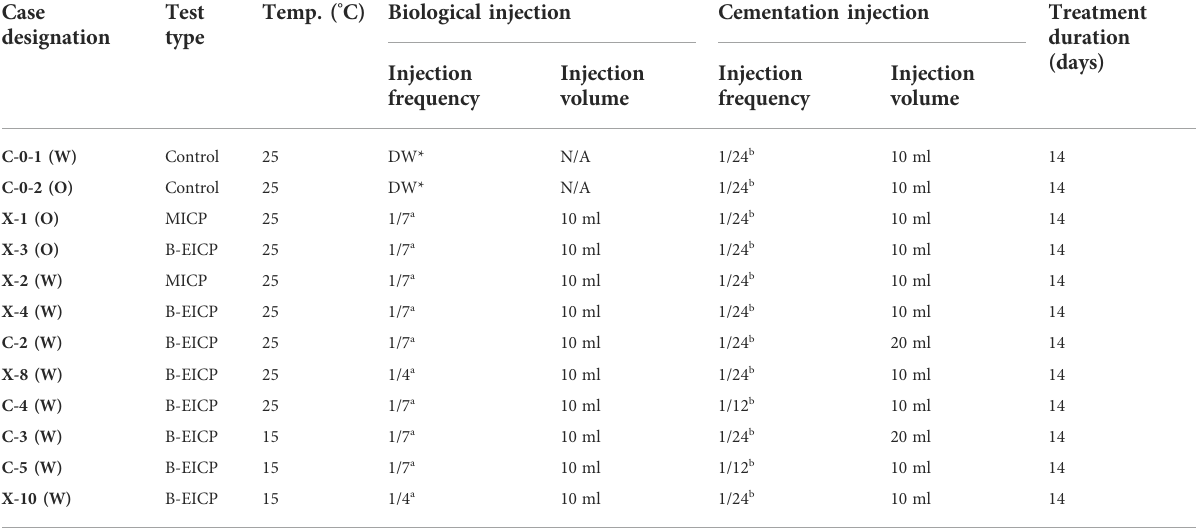
TABLE 1 Detail of all the test cases for B-EICP and MICP